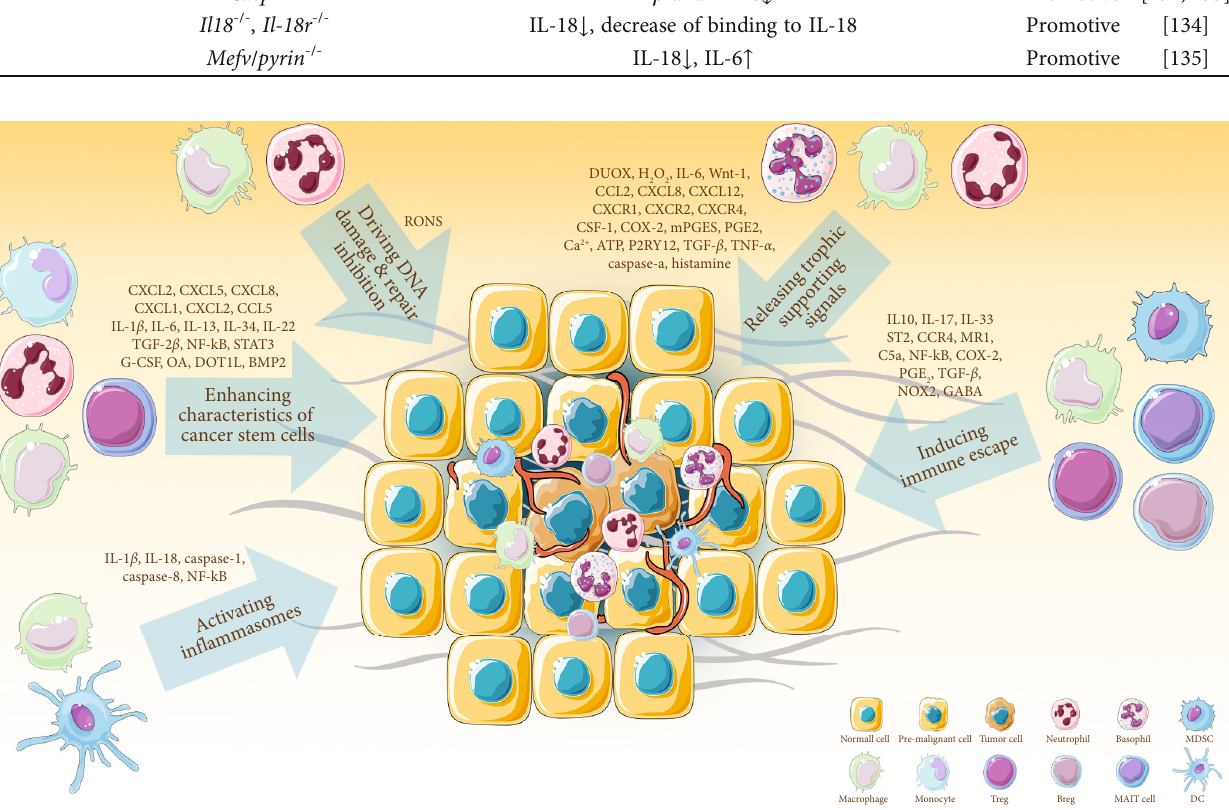
Figure 2: Tumor-promoting immune microenvironment in the early stages of tumorigenesis. Immune cell-mediated tumor-promoting mechanisms involve driving DNA damage and repair inhibition, releasing proliferation signals, inducing immune escape, enhancing characteristics of cancer stem cells, and activating in fl ammasomes. DUOX, dual oxidase; mPGES, microsomal prostaglandin E synthase; P2RY12, purinergic receptor P2Y12; OA, osteoactivin; ST2, suppression of tumorigenicity 2; MR1, MHC class I-related protein 1; NOX2, NADPH oxidase 2; GABA, gamma-aminobutyric acid; STAT3, signal transducer and activator of transcription 3; G-CSF, granulocyte colony-stimulating factor; DOT1L, disruptor of telomeric silencing 1-like; BMP2, bone morphogenetic protein 2; MDSC, myeloid- derived suppressor cell; Treg, regulatory T cell; Breg, regulatory B cell; MAIT cell, Mucosal-associated invariant T cell; DC, dendritic cell.